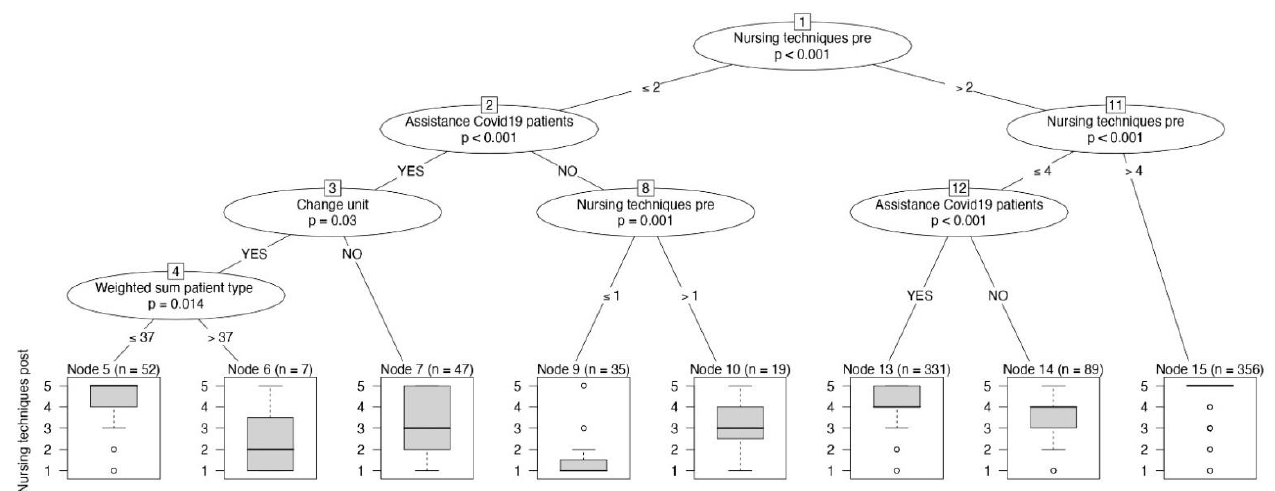
Figure 2. The conditional inference tree with the frequency of nursing techniques as dependent variable, reported at the bottom of the figure as boxplot.